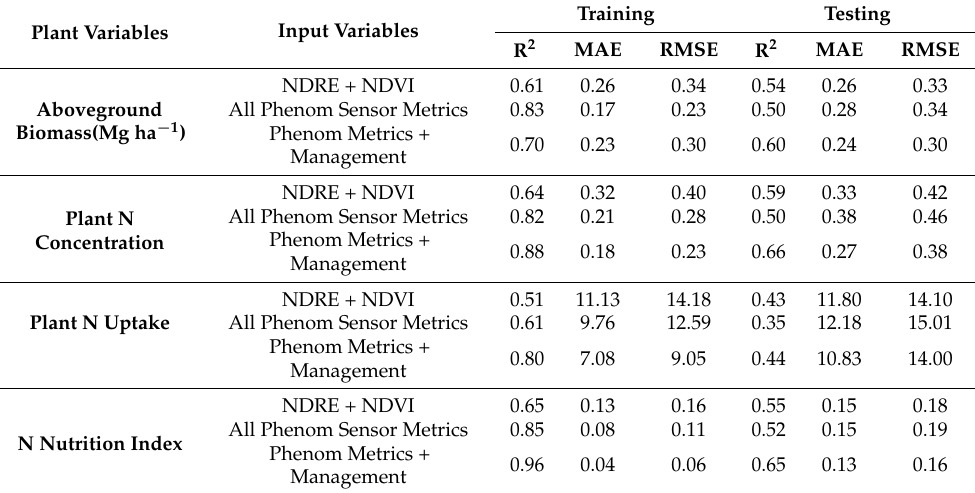
Table 4. eXtreme gradient boosted (XGB) model performance using different levels of Crop Circle Phenom sensor and management variables for predicting aboveground biomass, plant N concen- tration, plant N uptake, and N nutrition index.